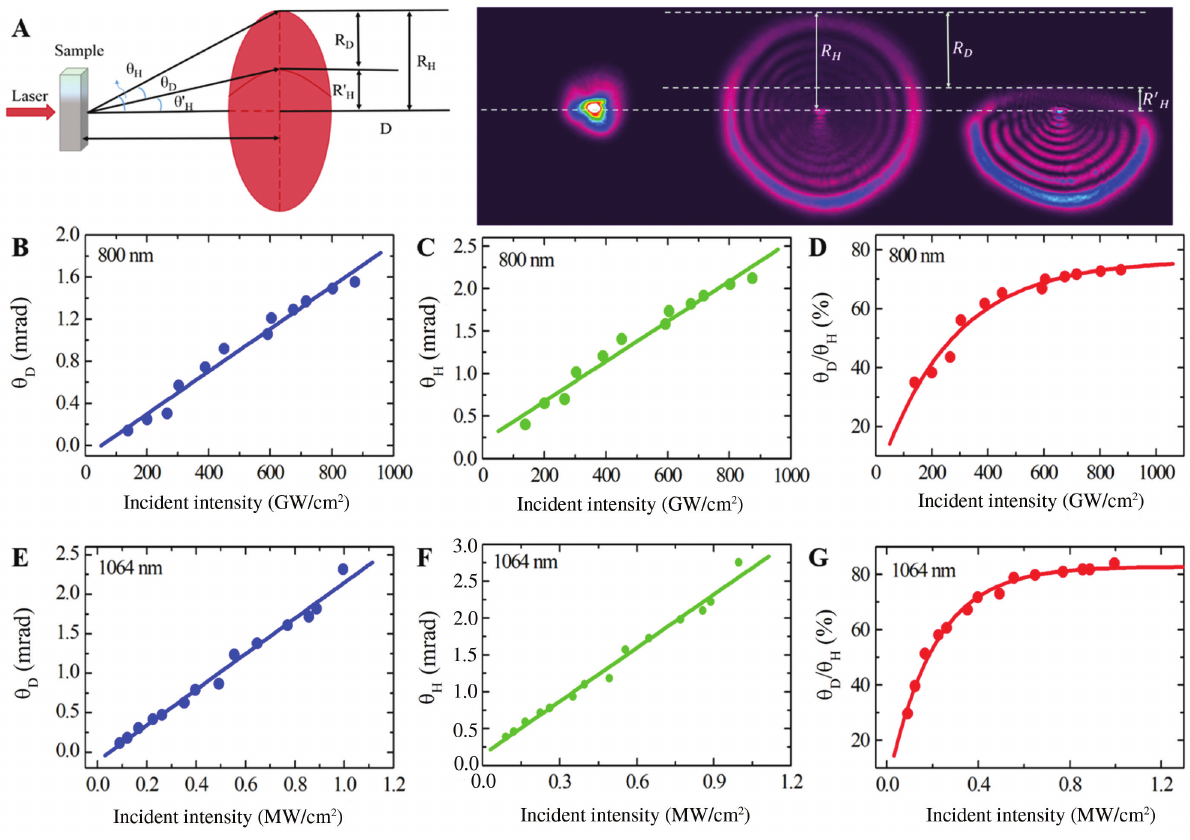
Figure 5: Light intensity-dependent collapse in SSPM experiments. (A) Image and schematic of diffraction ring distortion at 800 nm wavelength. The tendency of the half cone angle (B, E), collapse angle (C, F) and Δ n / n (D, G) as the increases of the intensity of 800 nm and 1064 nm wavelengths, 2 2